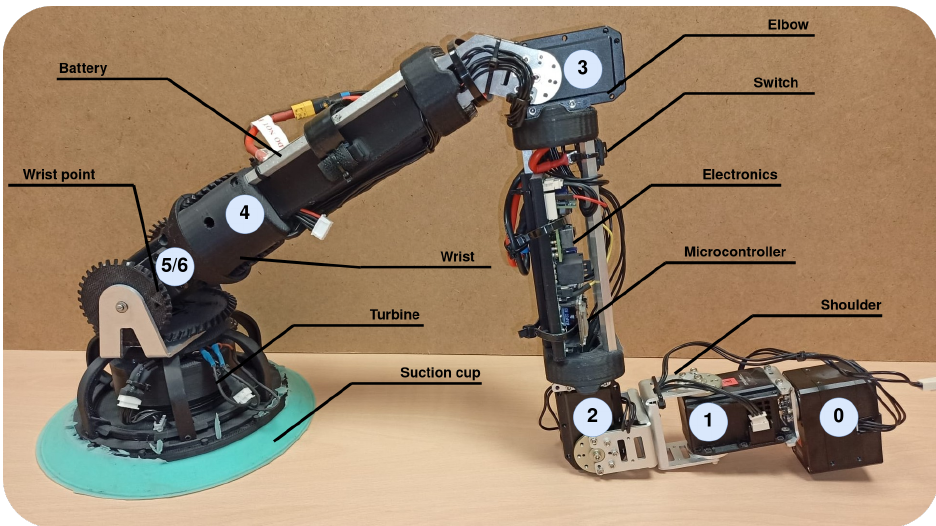
Figure 2. Robotic leg